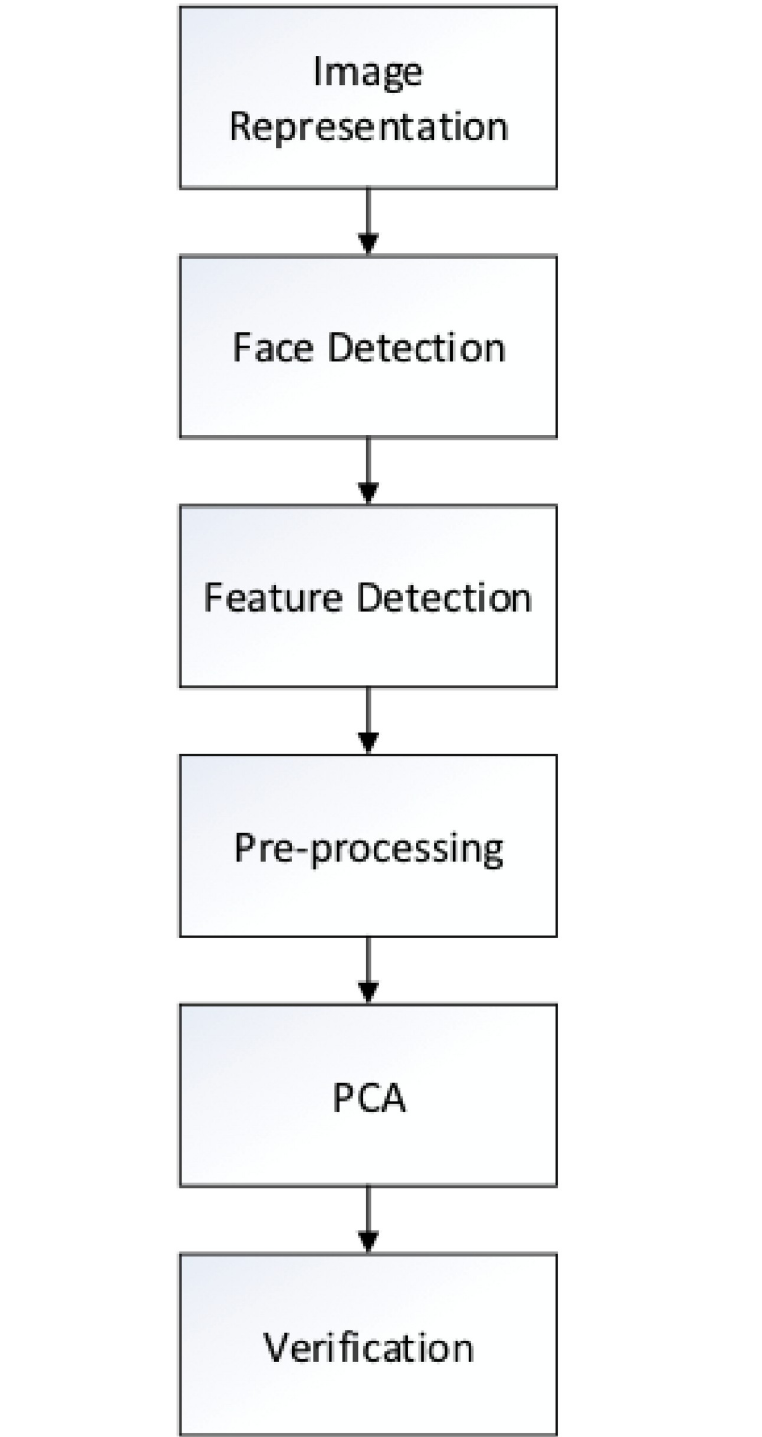
Fig 3. PCA-based face recognition system